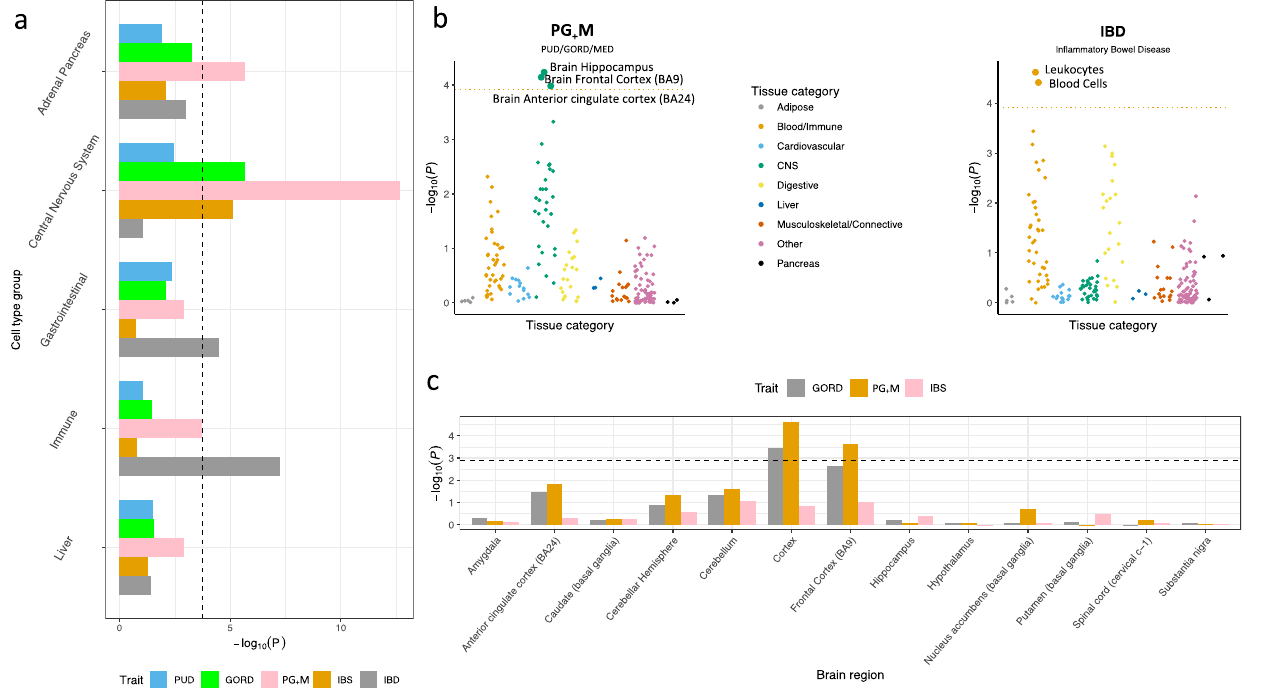
Fig. 5 Analyses of partitioning SNP-based heritability by different annotations. a SNP-based heritability enrichment analysis for each digestion phenotype partitioned by cell type groups annotated by histone marks. The dashed line represents the Bonferroni corrected signi fi cance threshold (0.05/(53 * 5 + 5 * 5)). b SNP-based heritability enrichment analysis for PG + M and IBD partitioned by cell types annotated using cell-type speci fi c gene expression data given the results from a . The dotted lines represent the Bonferroni correction threshold ( P <0.05/(205*2)). c SNP-based heritability enrichment analysis for GORD, PG + M, and IBS partitioned by cell types annotated using fi ne-scale GTEx brain gene expression data from 13 brain regions selected given the central nervous system enrichment results of these three phenotypes from a . The dashed line represents the Bonferroni correction threshold ( P